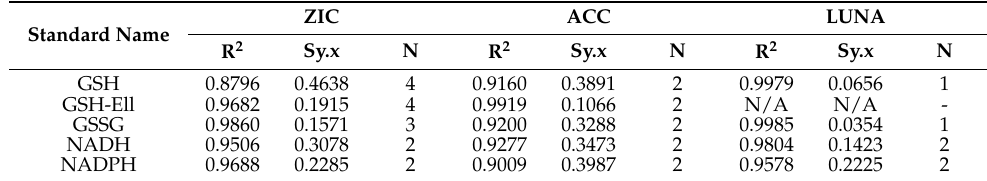
Table 2. Linear regression and goodness of fit (R-squared: R 2 ; and standard deviation of the residuals: Sy.x; Number of replicated measurements: N) for redox metabolites on three different columns.